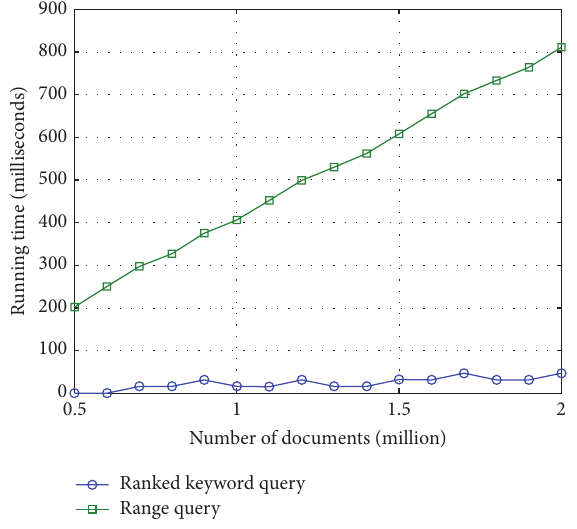
Figure 4: Time costs of the filter algorithms (single server, single query).